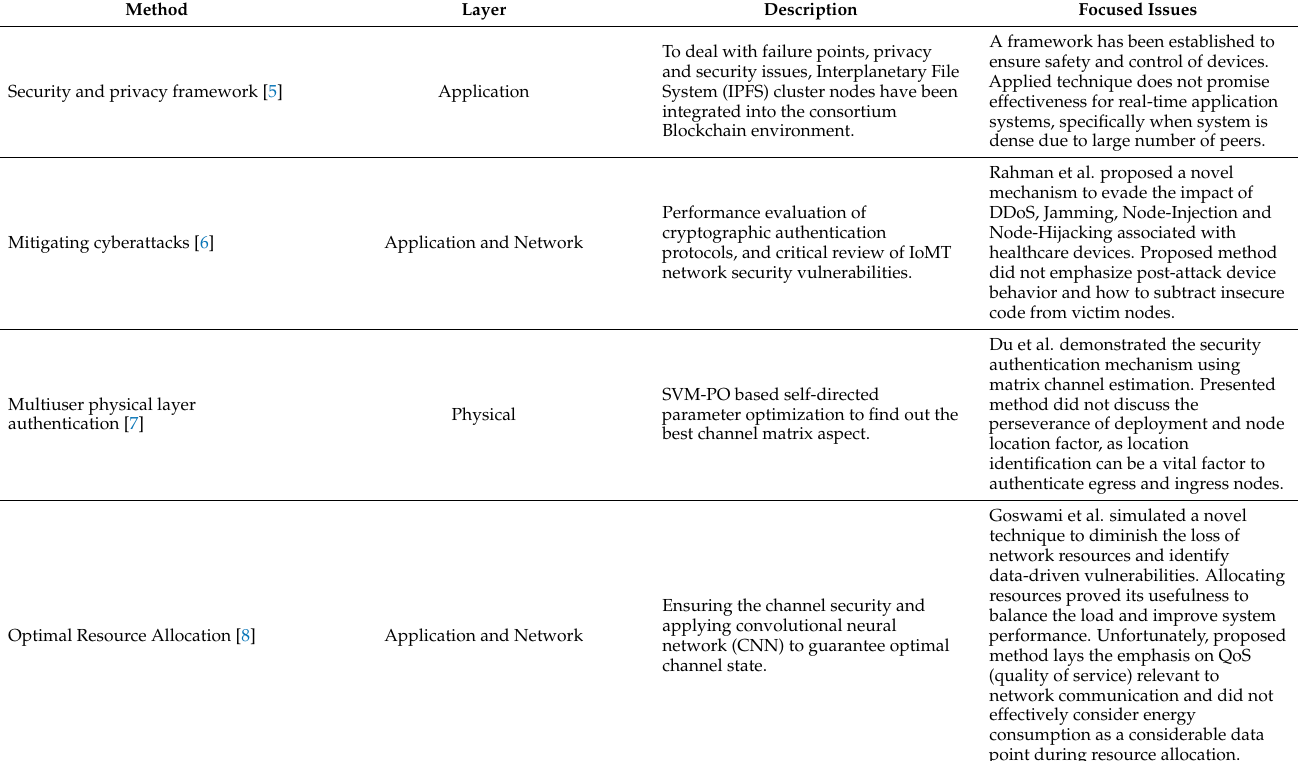
Table 1. Comparison of existing IoT (IIoT/IoMT (internet of medical things)) security